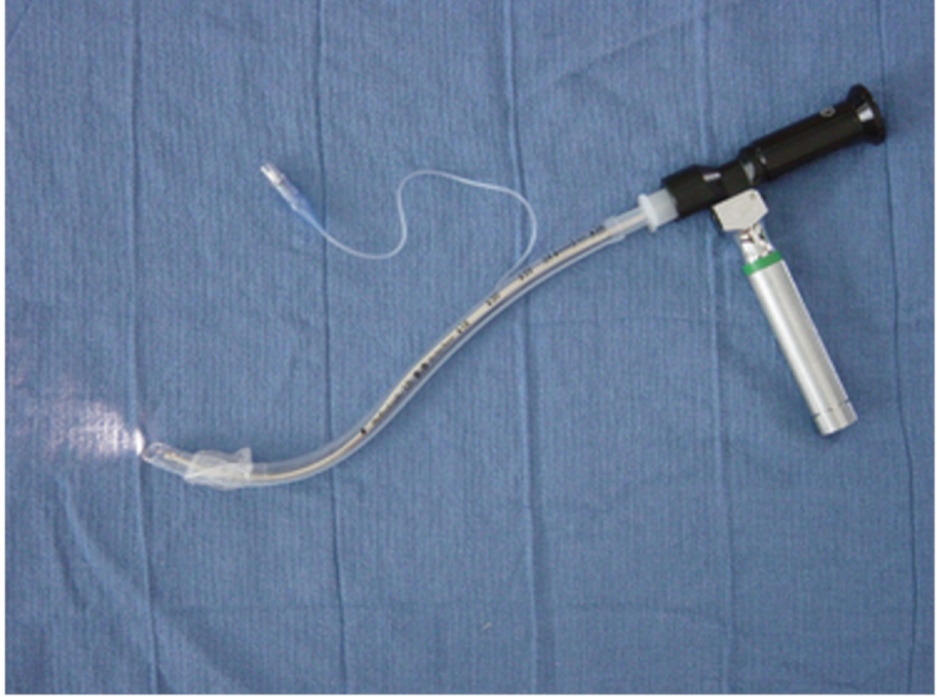
Figure 3. The Levitan FPS optical stylet inserted in a single lumen tracheal